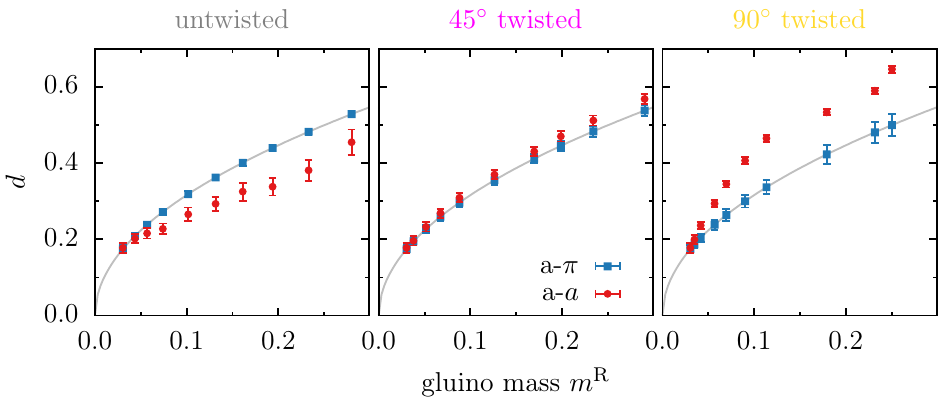
Figure 7 . The three plots correspond to twist angles α ∈ { 0 ◦ , 45 ◦ , 90 ◦ } marked in figure 6 with lines in gray, magenta and yellow. The same data of the 8 3 × 16 lattice is used and three clearly different mass hierarchies of the dominant contribution d are revealed. Some error bars are smaller than the symbol size. The gray solid lines visualize the dependence of the adjoint pion on the renormalized gluino mass, see eq.